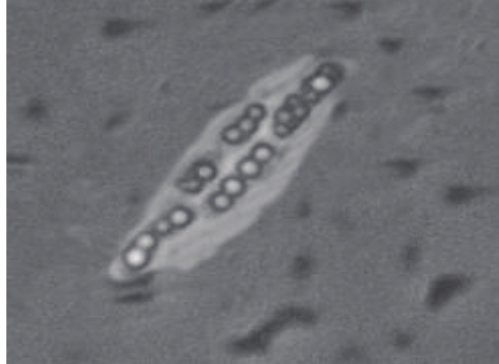
Figure 1: Phase Contrast Microscopic view of Pseudomonas sp. LDC-5 cells with accumulated PHA granules [24].